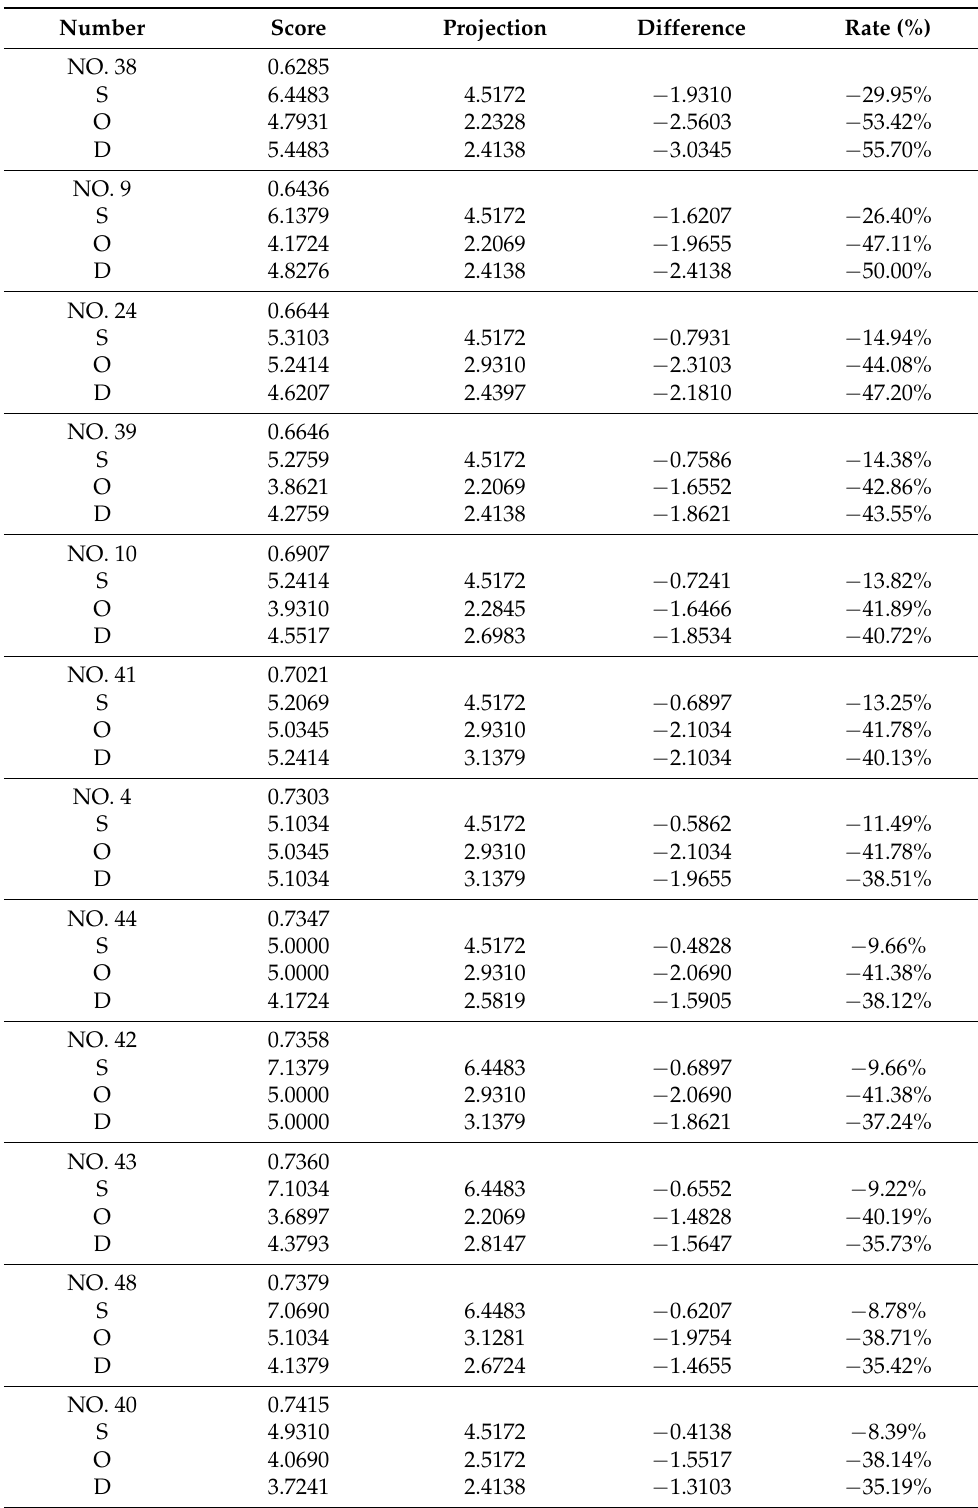
Table A1. Comparison between actual and ideal scores of failure